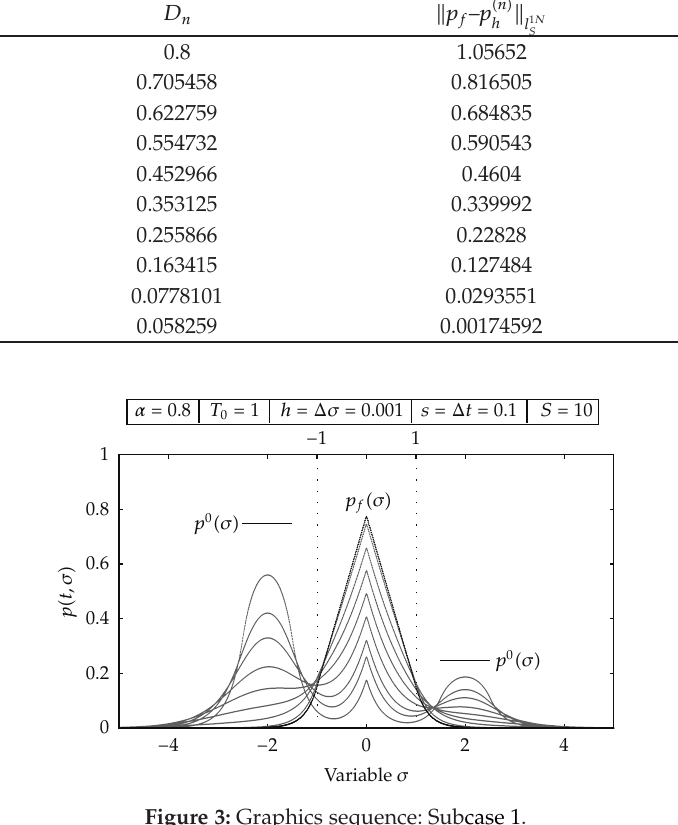
Table 1: Numerical results: Subcase 1